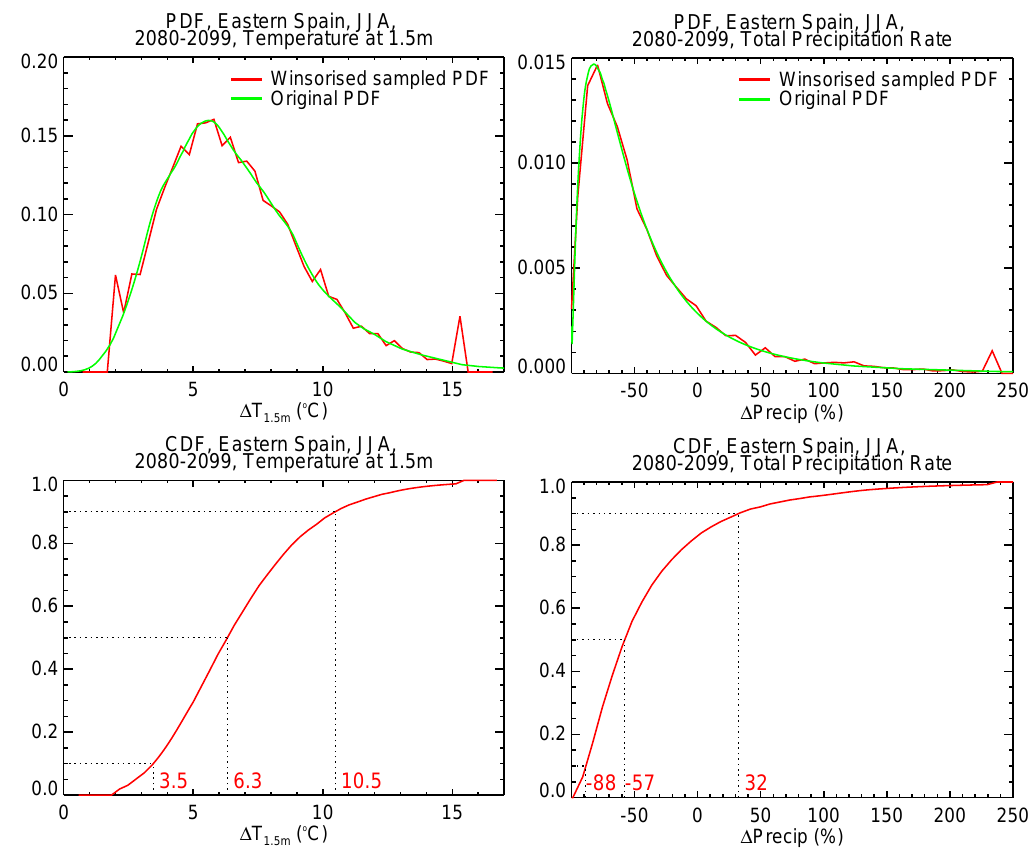
Fig. 7. PDFs and CDFs of surface temperature change and percentage precipitation change for the summer season for Eastern Spain for the period 2080–2099, relative to the 1961–1990 baseline period. (a) The marginal PDF and CDF for surface temperature change (red curves), corresponding to the Winsorised distribution in Fig. 6. The smooth PDF (green curve) is computed without Winsorisation from the original 10000 sample of Gaussian distributions for mean scaled response. The 10, 50 and 90% percentile values are indicated on the CDFs. (b) The marginal PDF and CDF for percentage precipitation change (red curves) corresponding to the distribution in Fig. 6, with the smooth PDF computed without Winsorisation given in